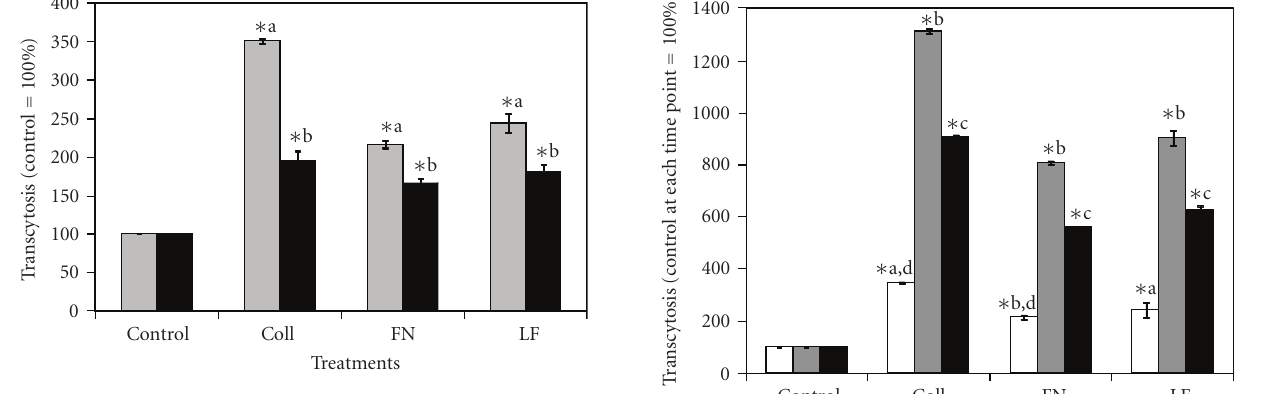
Figure 3: E ff ect of treatment with host proteins on transcytosis of Streptococcus uberis across bovine mammary epithelial cells treated with the receptor mediated endocytosis inhibitor mon- odansylcadaverine . Fibronectin (FN), collagen (Coll), or bovine lactoferrin (LF), pretreated S. uberis UT888 ( ) and UT366 ( ) were cocultured with bovine mammary epithelial cells treated with the receptor-mediated endocytosis inhibitor monodansylca- daverine (MDC), and colony forming units per ml (cfu/mL) of S. uberis that transcytosed bovine mammary epithelial cells were calculated at 60 minutes. Data are presented as the percentage of untreated controls (100%; UT888 = 6.0 × 10 2 ; UT366 = 3.0 × 10 2 ) and bars represent the standard error of the mean (SEM) of three independent experiments run in triplicate. ( ∗ ) indicates statistically significant di ff erences ( P < . 05) with the corresponding control. Means with similar superscript letters within each strain are statistically di ff erent ( P < . 05).